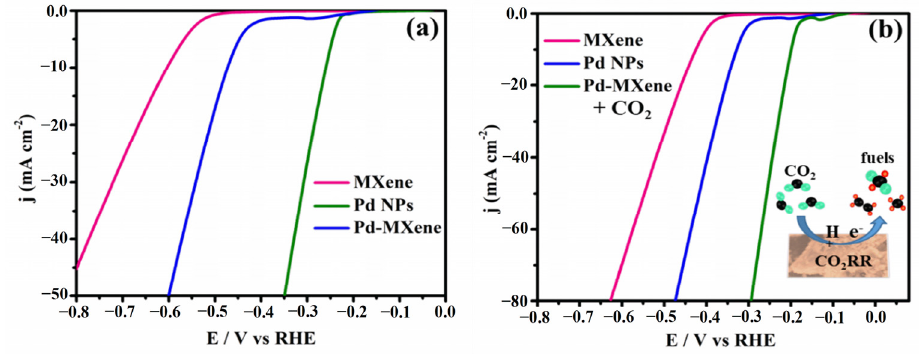
Figure 4. ( a ) LSV curves of Pd, MXene, and Pd-MXene electrodes at 10 mV s − 1 in 1.0 M KHCO 3 as the electrolyte and ( b ) LSV curves of Pd, MXene, and Pd-MXene electrodes at 10 mV s − 1 in CO 2 -saturated 1.0 M KHCO 3 as the